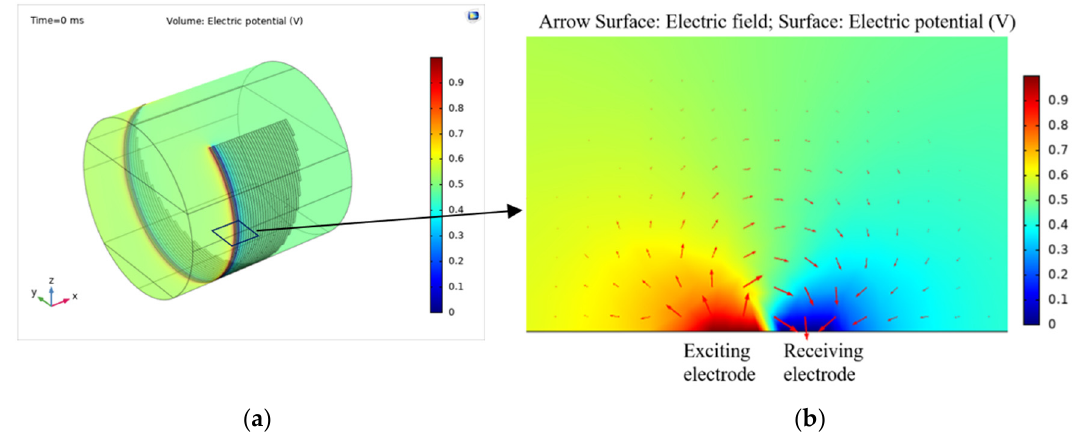
Figure 8. Electric field vectors and electric potential distribution for one electrode pair of the sensor calculated by COMSOL Multiphysics: ( a ) 3D view of electric potential distribution for the model; ( b ) cross section electric field vectors and electric potential distribution of one electrode pair.